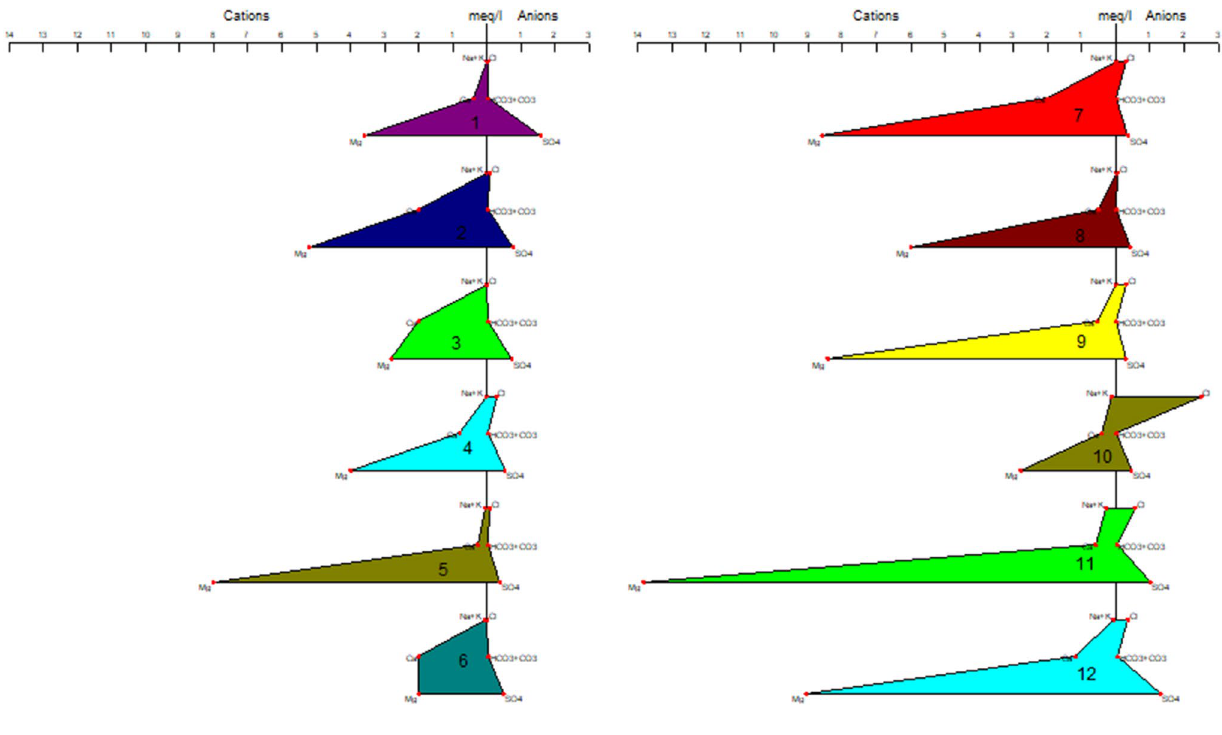
Fig. 6 Stiff plot for the rainy season (water samples 1–12)